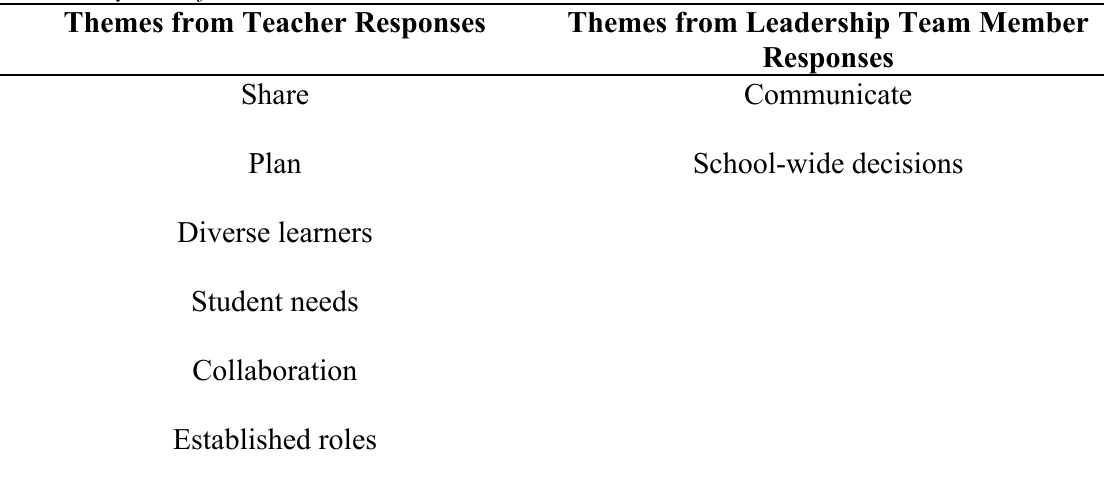
Commonly Identified Themes Themes from Teacher